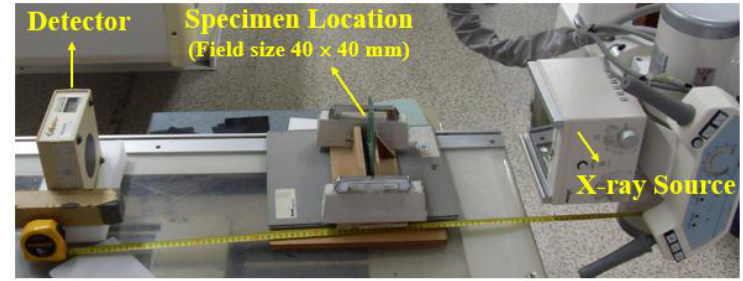
Figure 1. Test configuration of X-ray transmission.